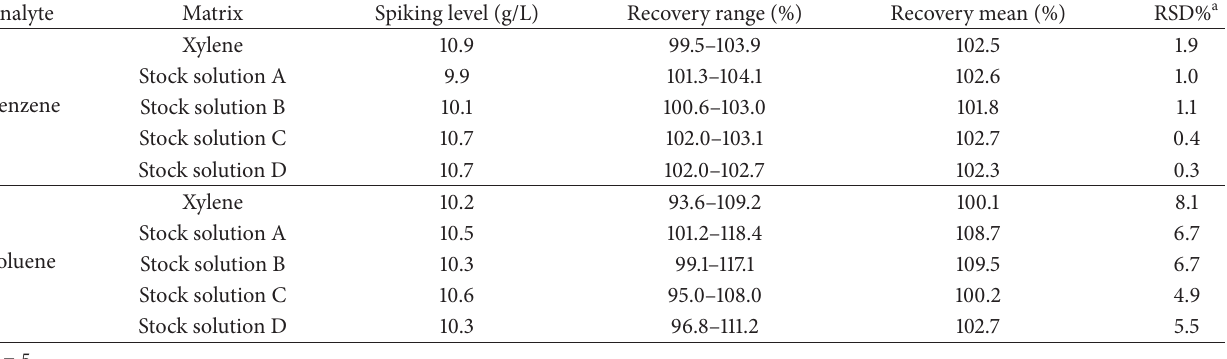
Table 1: The results of accuracy and precision (RSD%) studies for different matrices spiked with accurate benzene and toluene.